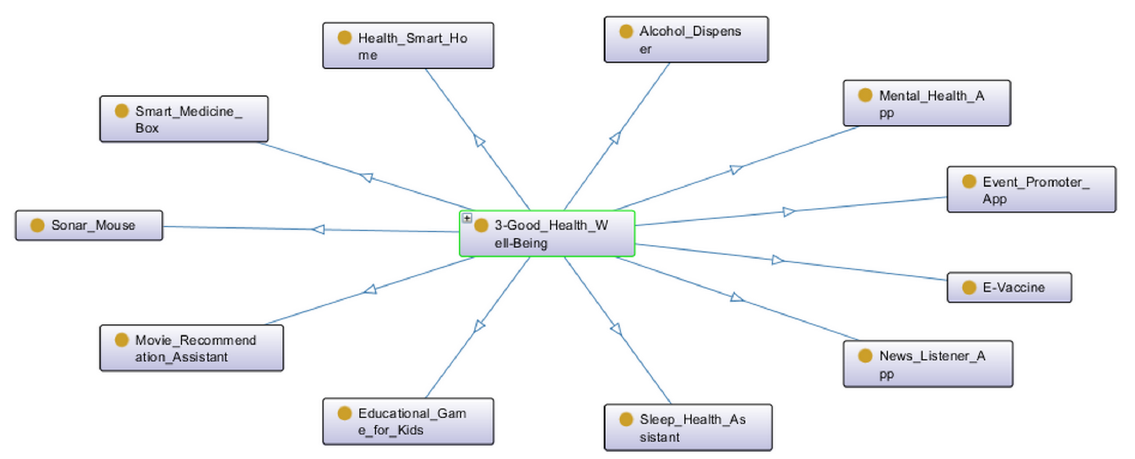
Figure 17. Projects related to the SDG